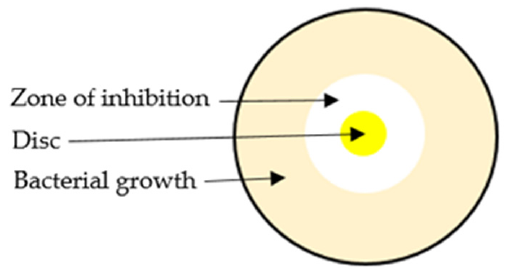
Figure 5. Schematic representation of disc diffusion method.